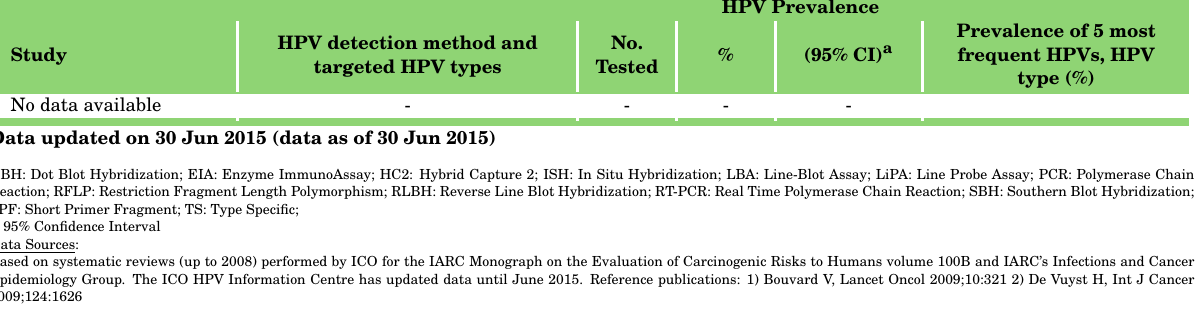
Table 29: Studies on HPV prevalence among vaginal cancer cases in Peru